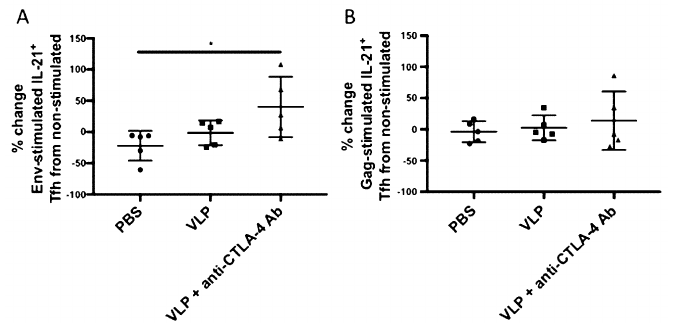
Figure 2. CTLA-4 blockade enhances Env-specific IL-21+ Tfh cells. Lymph nodes were harvested